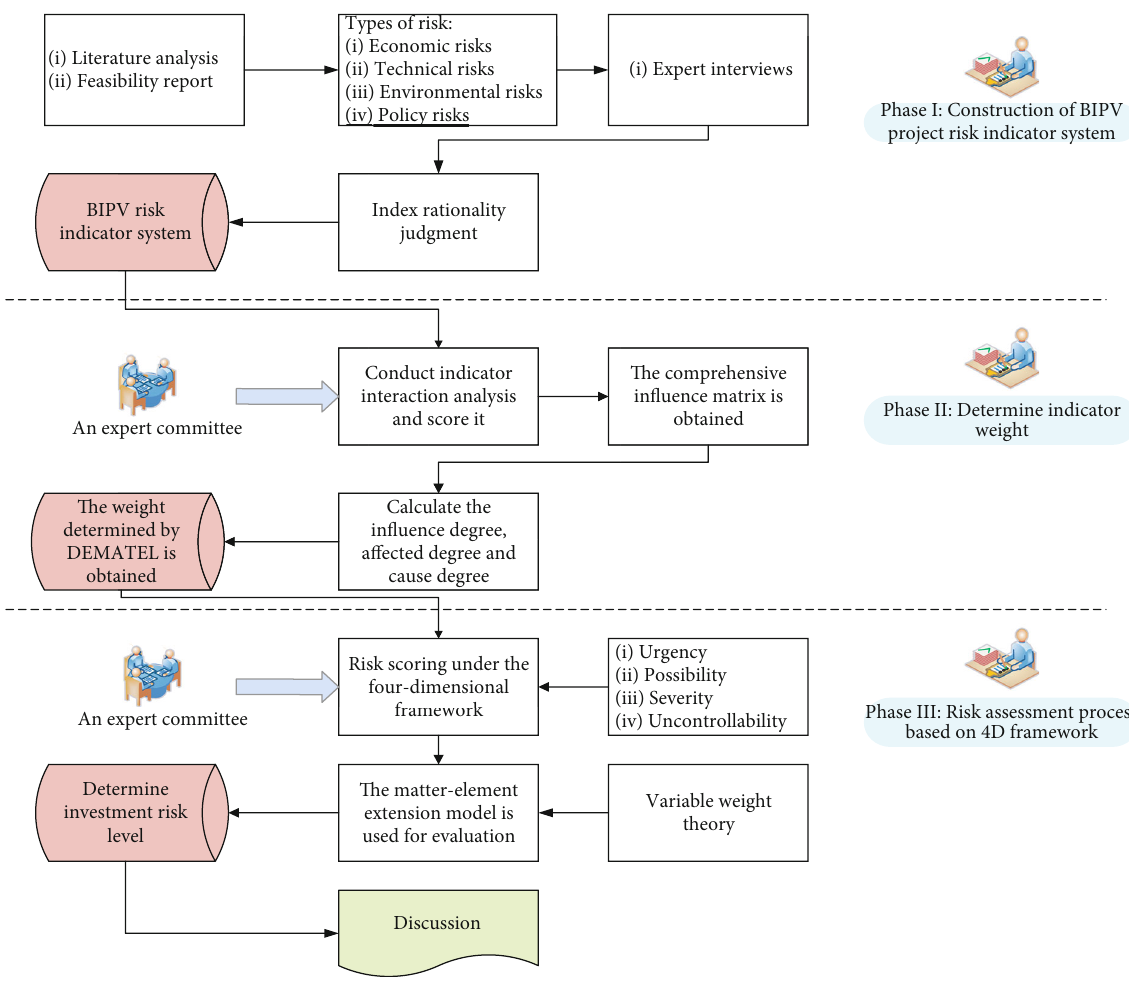
Figure 1: Research